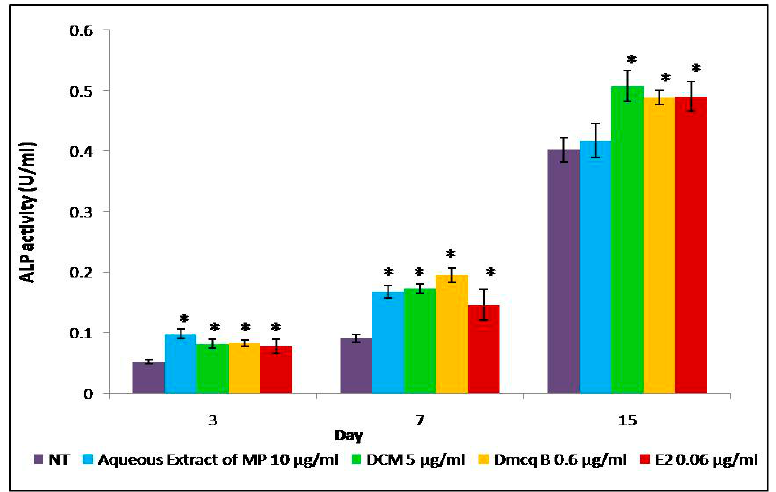
Figure 6. Effects of M. pumilum var. alata crude aqueous extract, DCM fraction, Dmcq B and E2 (positive control) on ALP activity during 15 Days of differentiation induction. DCM fraction and